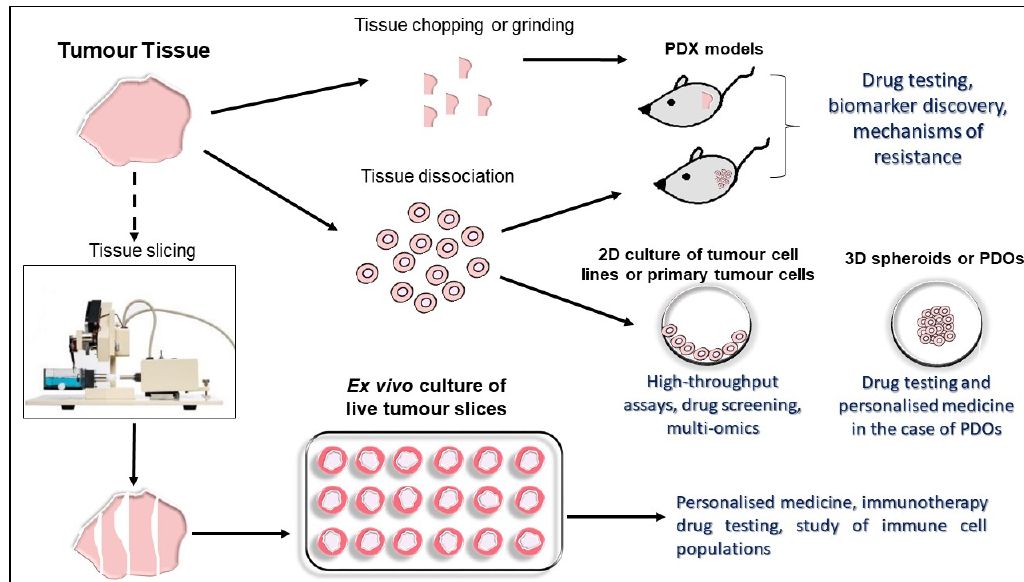
Figure 1. Overview and main applications of preclinical tumor models.